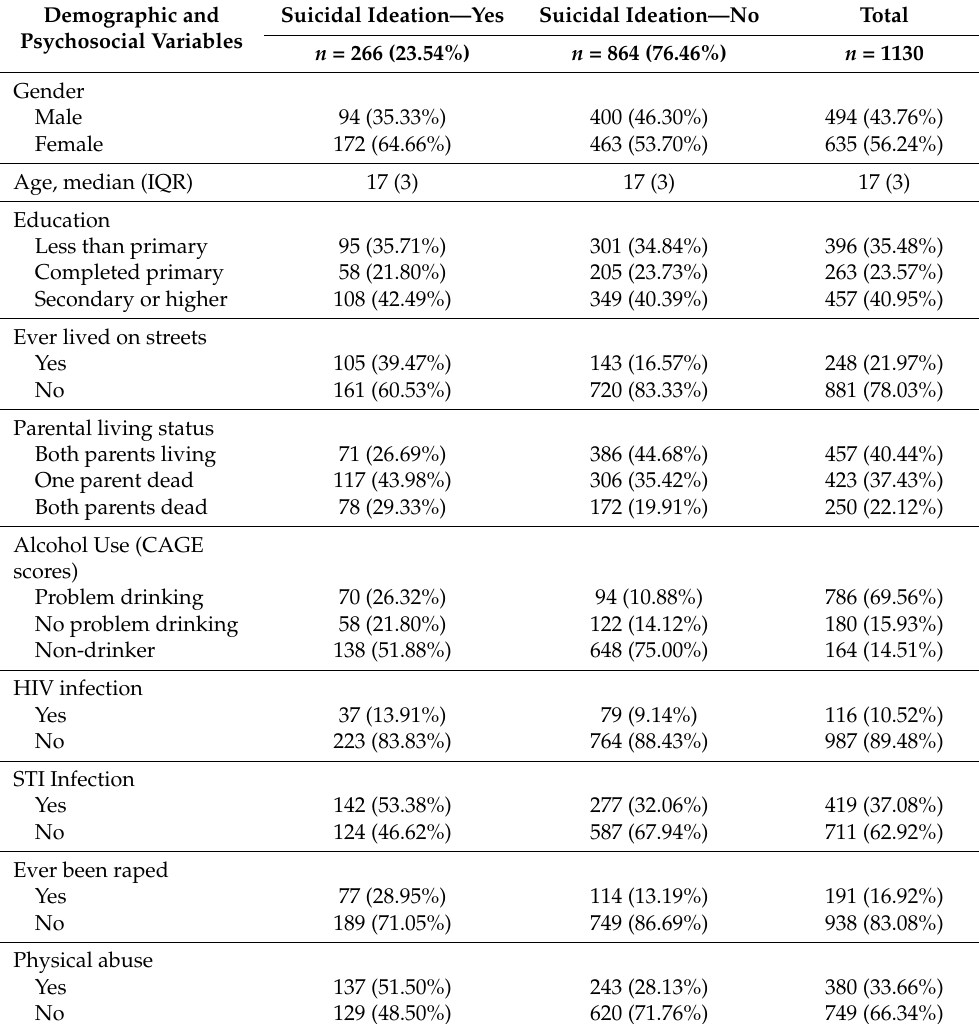
Table 1. Characteristics of youth living in the Slums of Kampala who report suicidal ideation ( n =